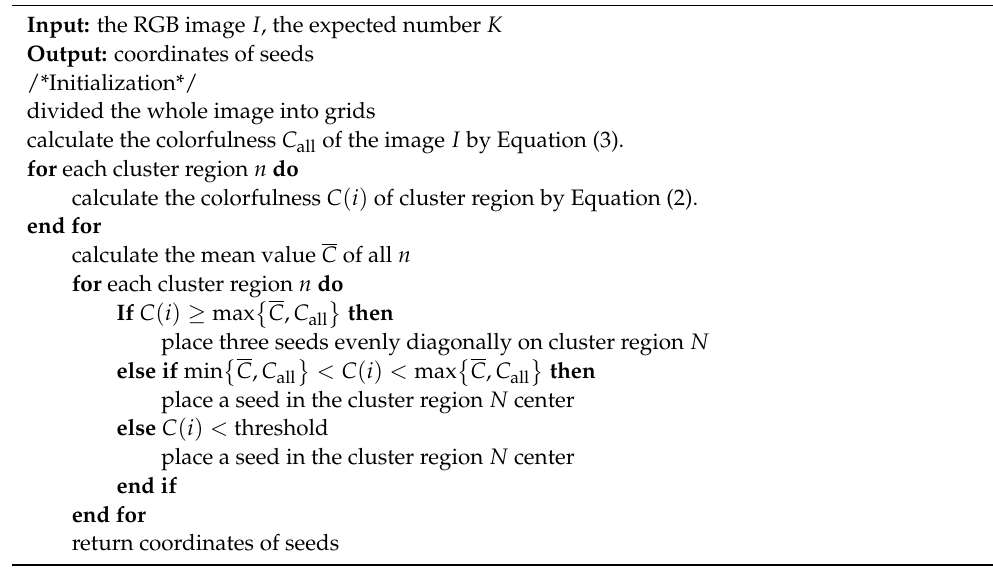
Algorithm 2. Seed initialization